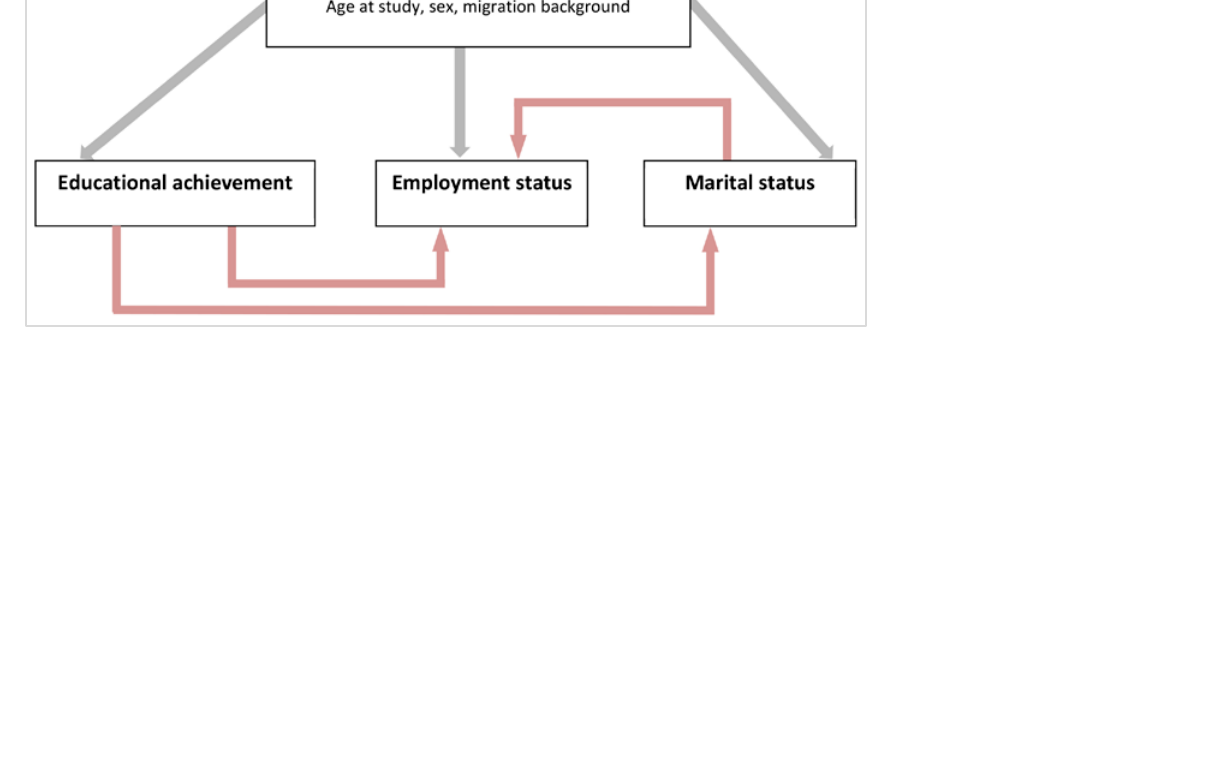
Figure S1: Causal pathway regression models in the combined dataset of teenage and young adult cancer survivors and